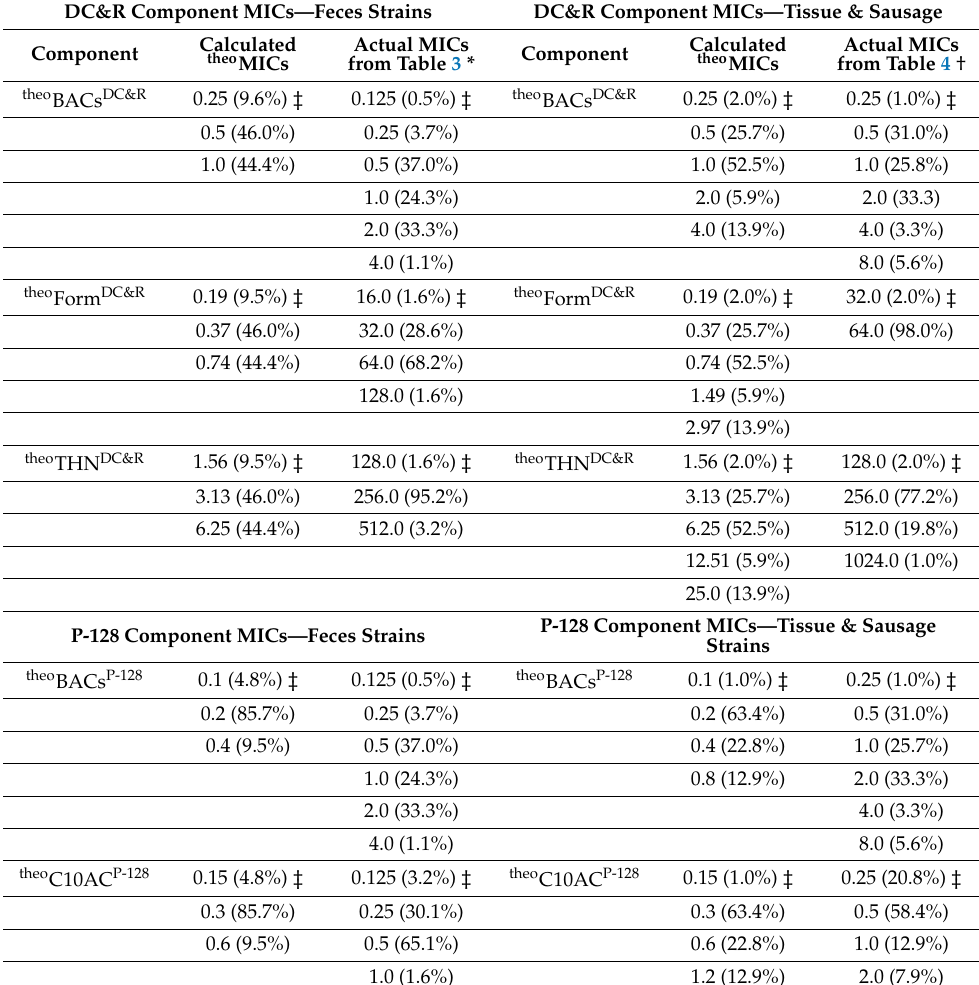
Table 7. Comparison of the calculated theoretical MICs ( theo MICs) for components of DC&R CP and P-128 CP to the actual MIC levels of components required for inhibition of 63 Staphylococcus aureus strains isolated from feces to 101 S. aureus strains from swine mandibular lymph node tissue and commercial pork sausage meat in µ g/mL. MIC = minimum inhibition concentration.